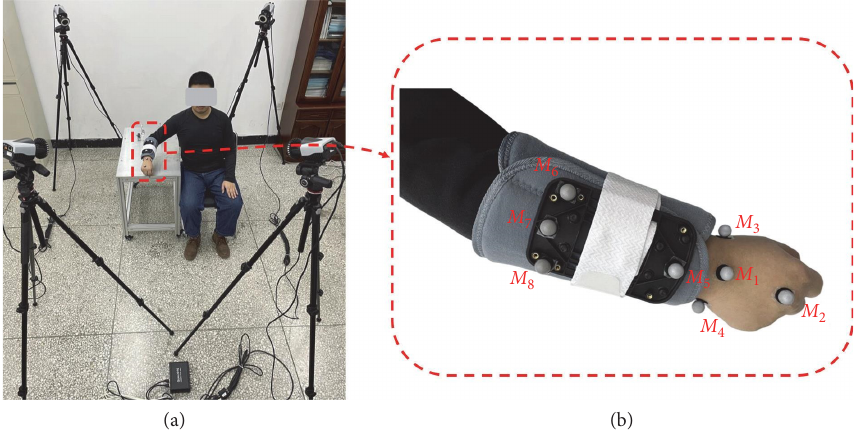
F IGURE 2: Measurement experiments of physiological motion space. (a) Overall equipment. (b) Placed re fl ective markers.